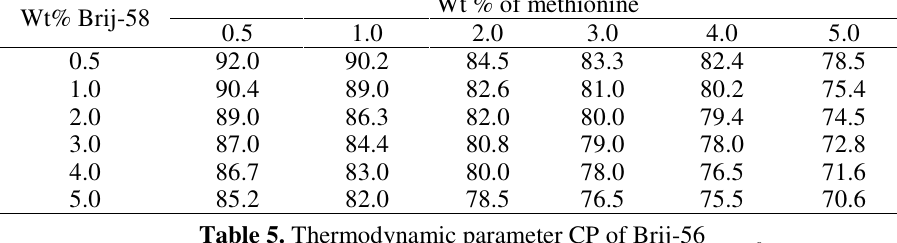
Table 5. Thermodynamic parameter CP of Brij-56